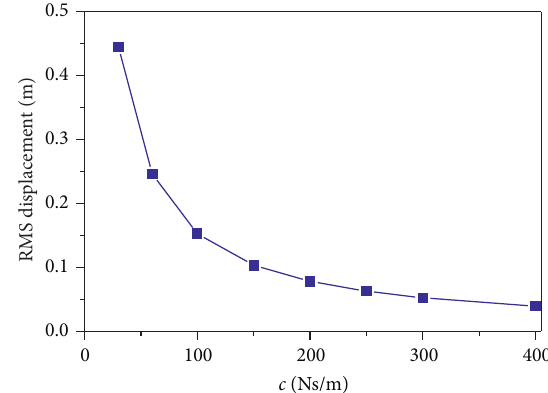
Figure 6: The relationship between the root mean square of structural displacement response and the viscosity coefficient of damper.